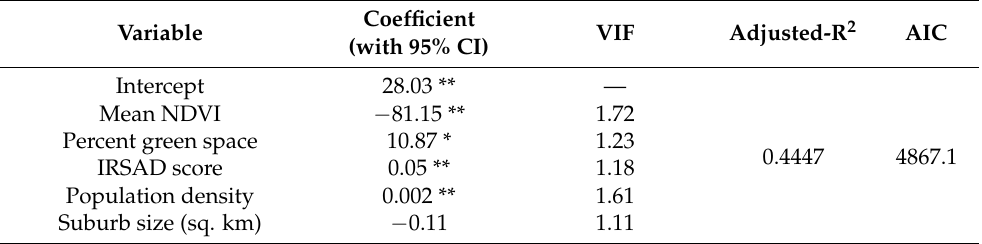
Table 2. OLS parameter estimates: Association between Walk Score ® and mean NDVI after adjusting with other covariables. Coefficient VIF Adjusted-R 2 AIC Variable (with 95% CI) Intercept 28.03 ** — 4867.1Mean NDVI − 81.15 ** 1.72 Percent green space 10.87 * 1.23 0.4447 IRSAD score 0.05 ** 1.18 Population density 1.61